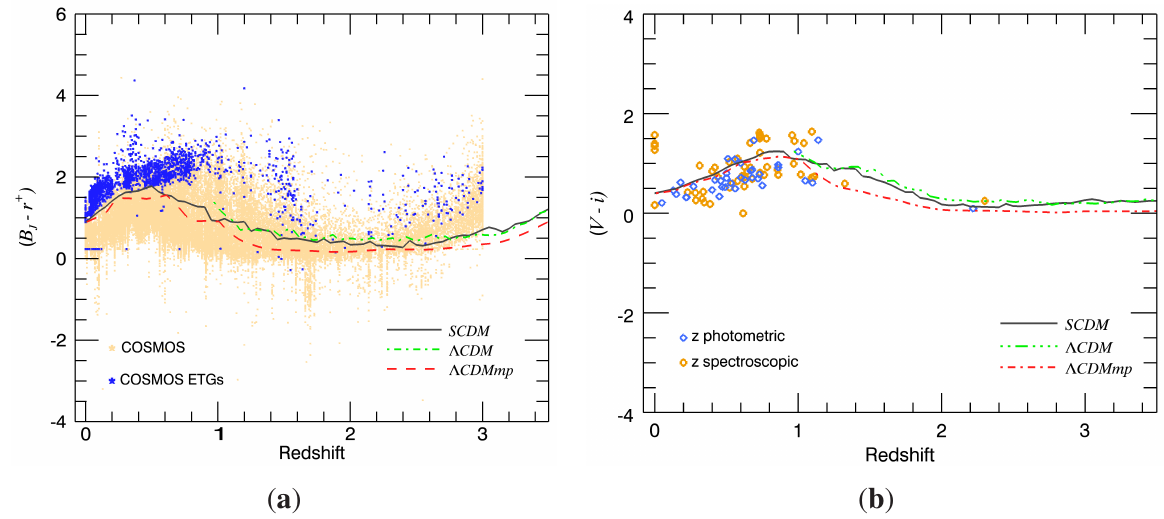
Figure 18. ( a ) Cosmological evolution with redshift for the ( B survey. Both pass-bands are those of the Subaru Telescope. All galaxies of the catalog are shown in yellow. The ETGs selected with the pipeline morphological T parameter are marked in